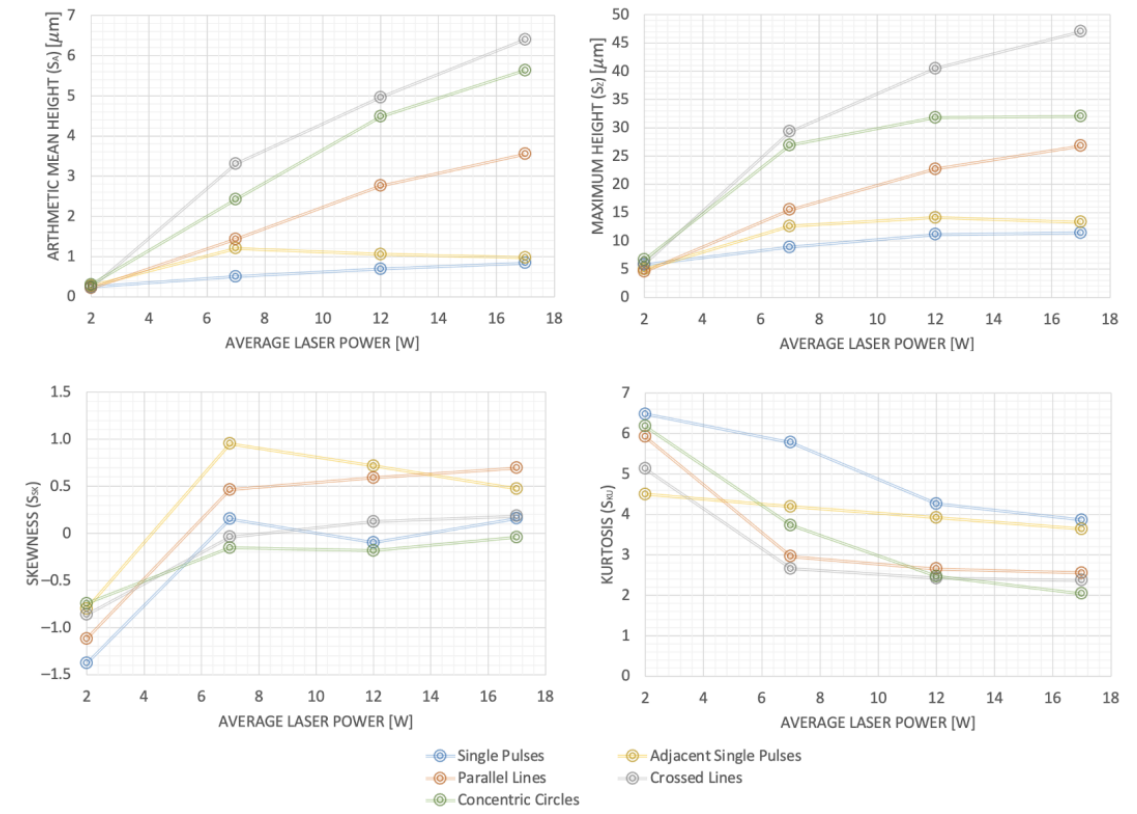
Figure 8. Arithmetic mean height, S a , maximum height, S z , skewness, S sk , and kurtosis, S ku , of laser-textured surfaces without coating as a function scanning strategy and laser power.